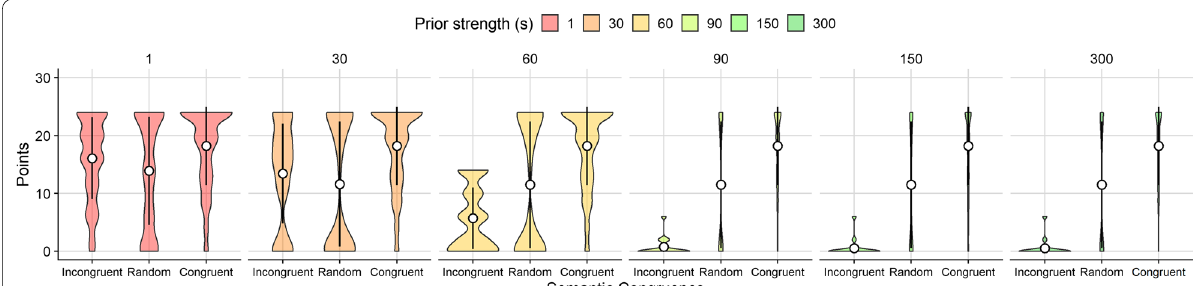
Fig. 6 Violin plots showing showing points earned by the ideal observer for different levels of prior strength (columns), as a function of semantic congruence. Low values for prior strength simulated a strong reliance on recent experience, while high values simulated a strong reliance on prior beliefs. Each violin plot corresponds to N 1500 simulated trials. White circles indicate the mean and error bars represent =